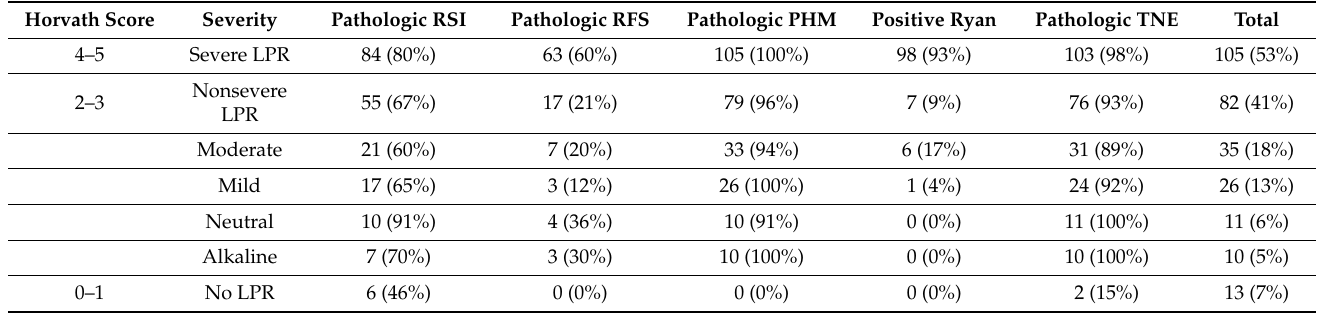
Table 1. Study outcome for each approach in detecting LPR conforming to the Horvath Score ( n = 200). Horvath